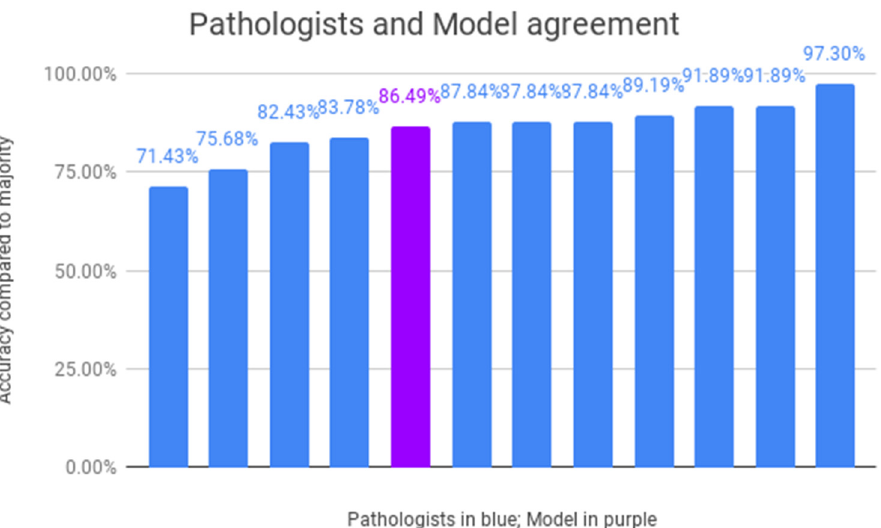
Figure 4. Performance of pathologists and U-NET. Accuracy of each pathologist is depicted in blue. Accuracy of our model is depicted in purple. Correct classification for each case was determined by majority voting across pathologists' representation.